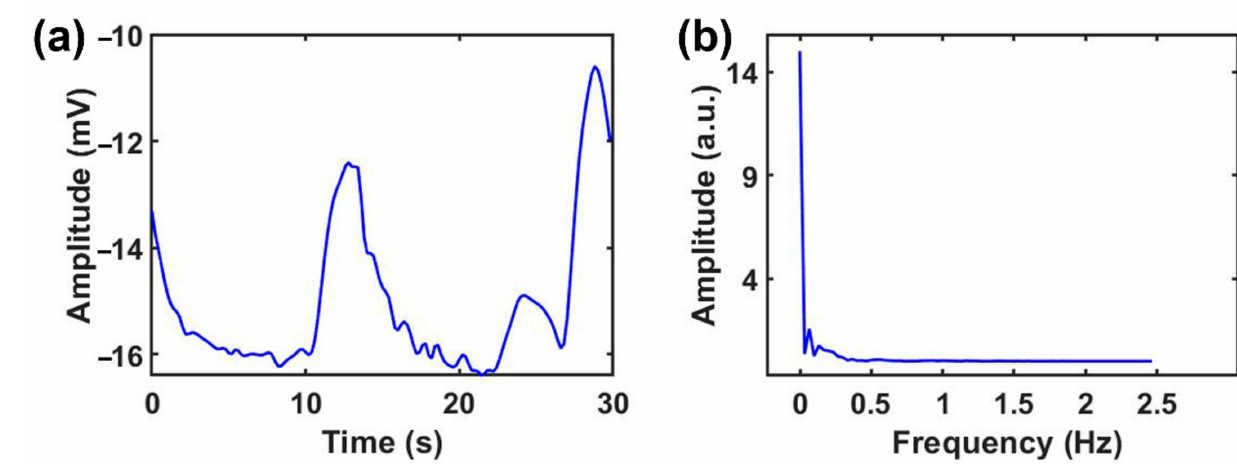
Figure 2. Characteristics the of SP signal. ( a ) The original signal spectrum, and ( b ) frequency spectrum analysis of the